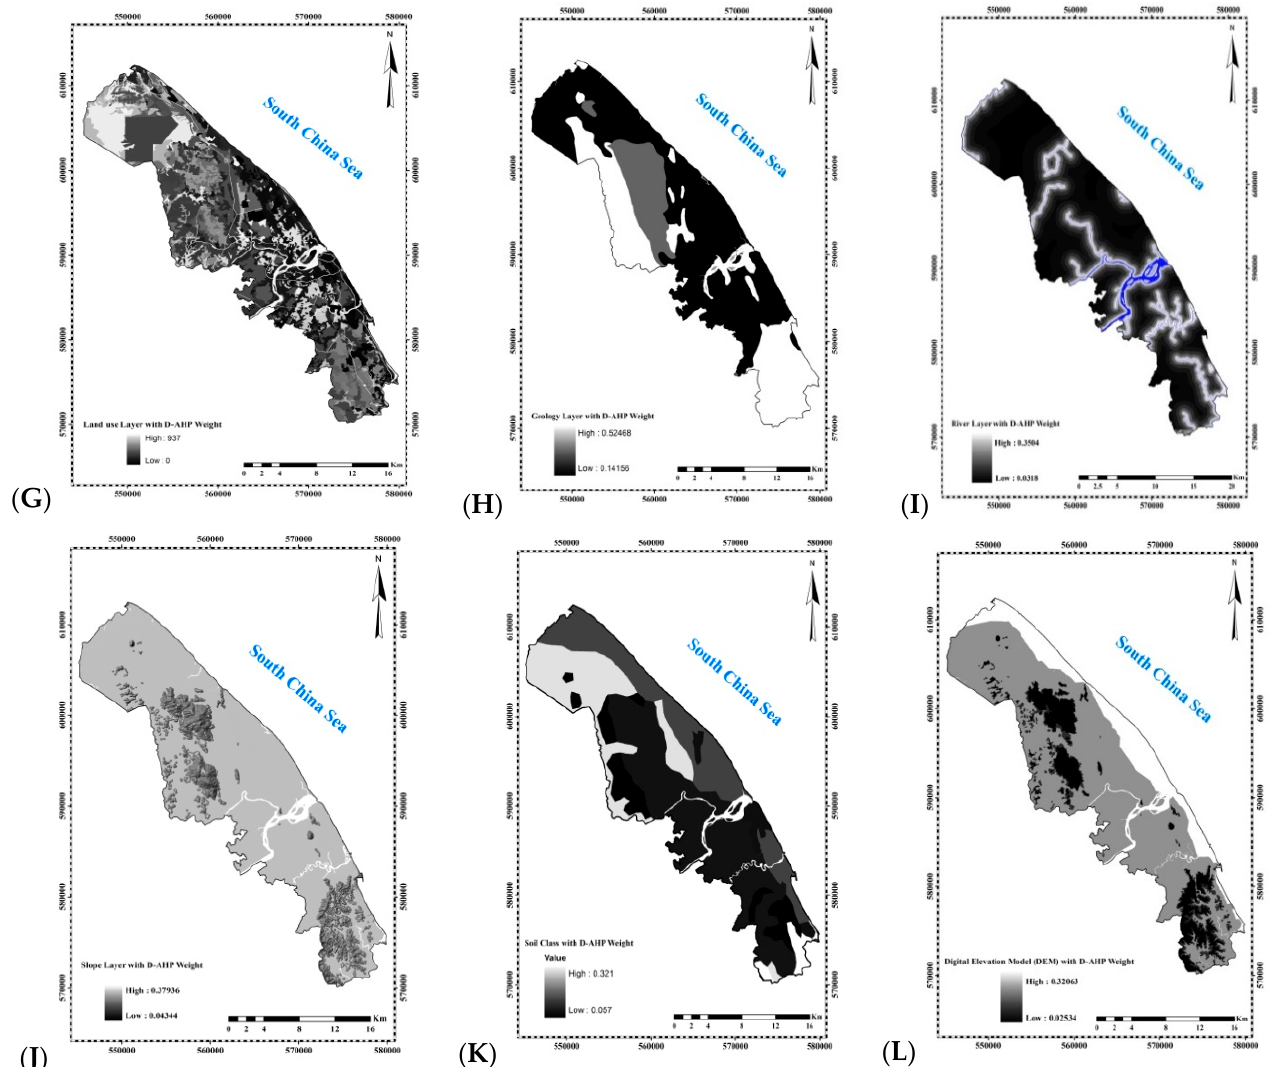
Figure 6. Environmental GIS layers class: ( A ) Land Use, ( B ) Geology, ( C ) River, ( D ) Slope, ( E ) Soil ( F ) Digital Elevation Map (DEM). Environmental GIS layers based on calculations of Delphi-AHP weights, ( G ) Land use layer, ( H ) Geology layer, ( I ) River layer, ( J ) Slope layer, ( K ) Soil layer, ( L ) Digital Elevation Map (DEM) layer.